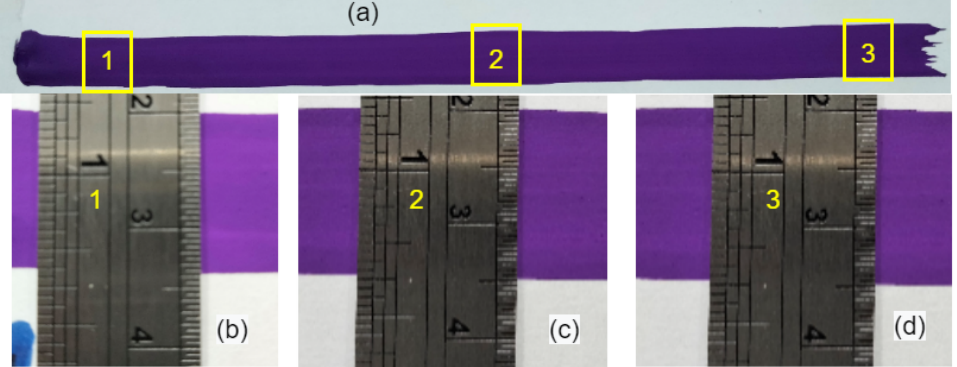
Figure 14. The final results of robot painting: ( a ) Complete painted trajectory; ( b – d ) Show the 1, 2, and 3 points of ( a